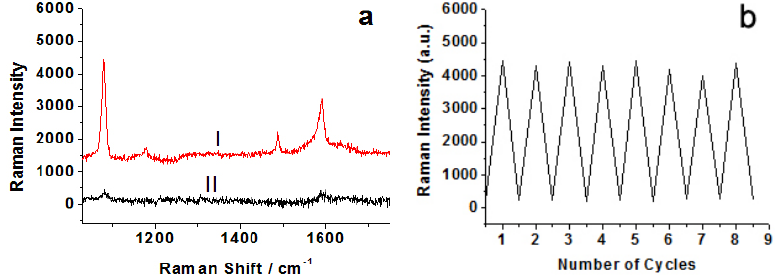
Figure 3. ( a ) SERS spectra of 4-aminothiophenol (ATP) molecules measured on nanostructured switch devices at “colse” (I) and “open” states (II), respectively. The spectra were recorded by using 633 nm laser lines. ( b ) A plot of the Raman intensity at 1078 cm − 1 for 4-ATP molecules as a function of the number of cycles. High and low Raman absorbance maxima values indicate the devices at the “close” and the “open” states, respectively.